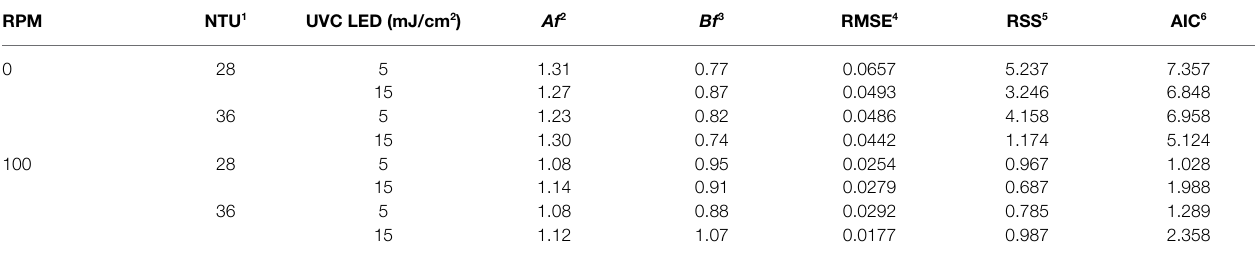
TABLE 3 | Comparison of the predictive models in terms of the model-selection criteria including the accuracy factor, bias factor, RMSE, RSS, and AIC based on goodness of fit. RPM NTU 1 UVC LED (mJ/cm 2 ) Af 2 Bf 3 RMSE 4 RSS 5 AIC 6 0